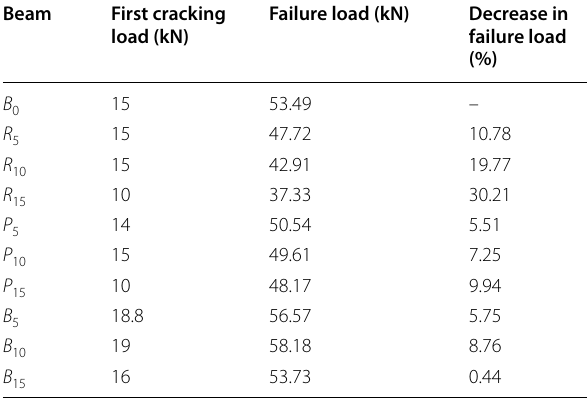
Table 1 Load-carrying capacity of the